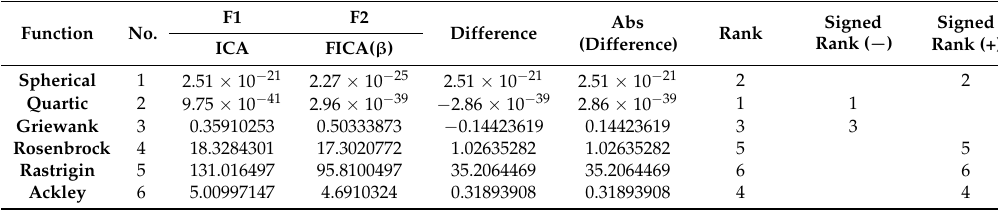
Table 8. Parameters for the statistical